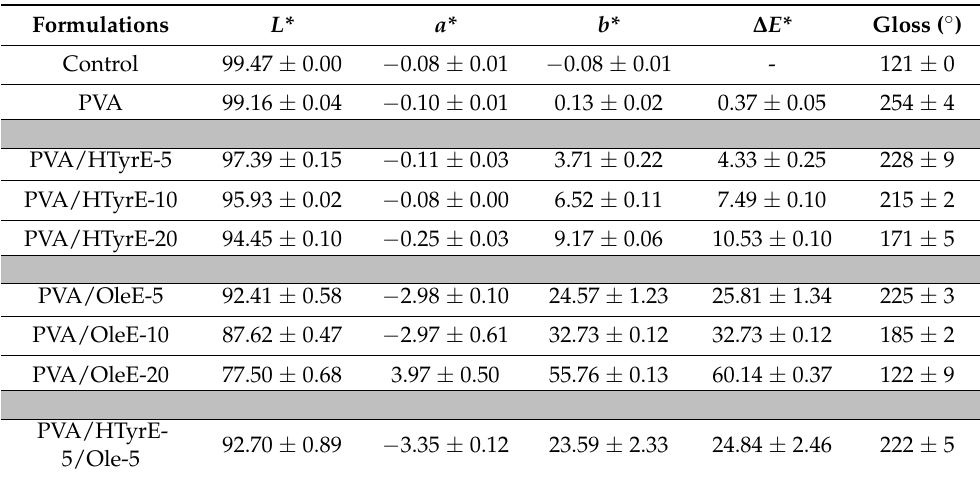
Table 1. Color coordinates of PVA/HTyrE and PVA/OleE